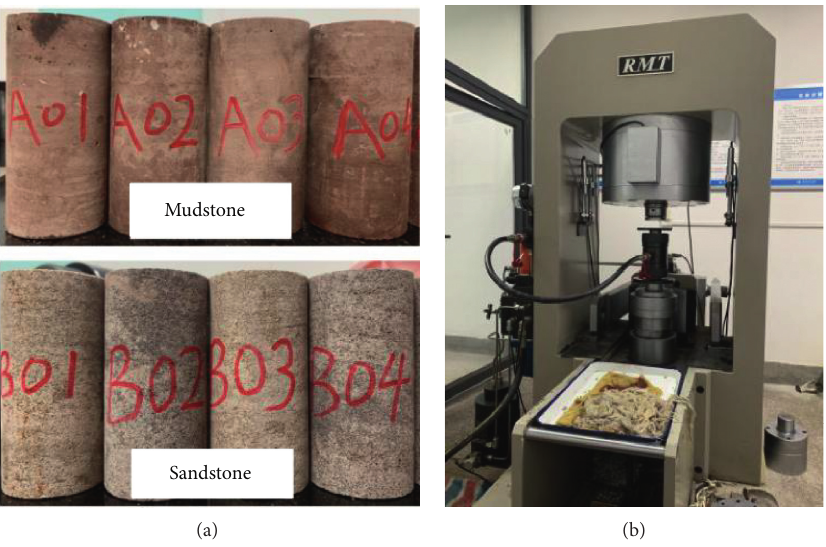
Figure 2: Real scene of rock specimen and test device. (a) Rock sample. (b) Laboratory